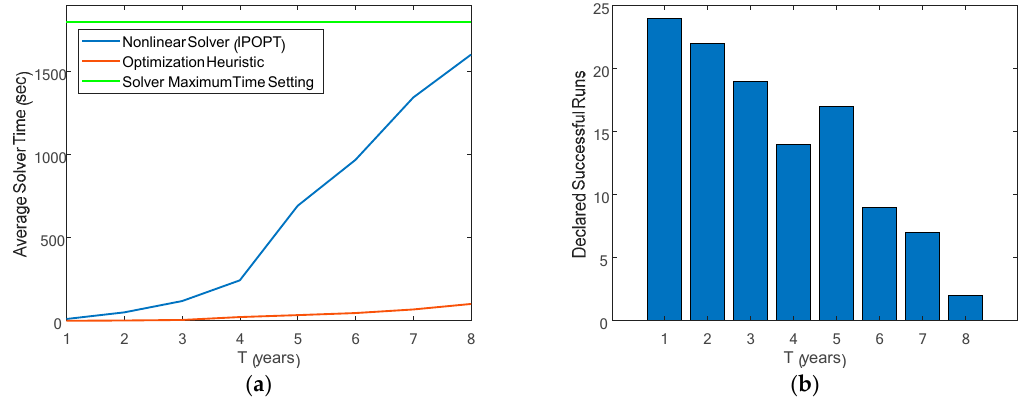
Figure 5. ( a ) Average solution time for T = 1...8 with solver time limit of 1800 seconds; ( b ) Successful runs of IPOPT out of 25 for T = 1...8.